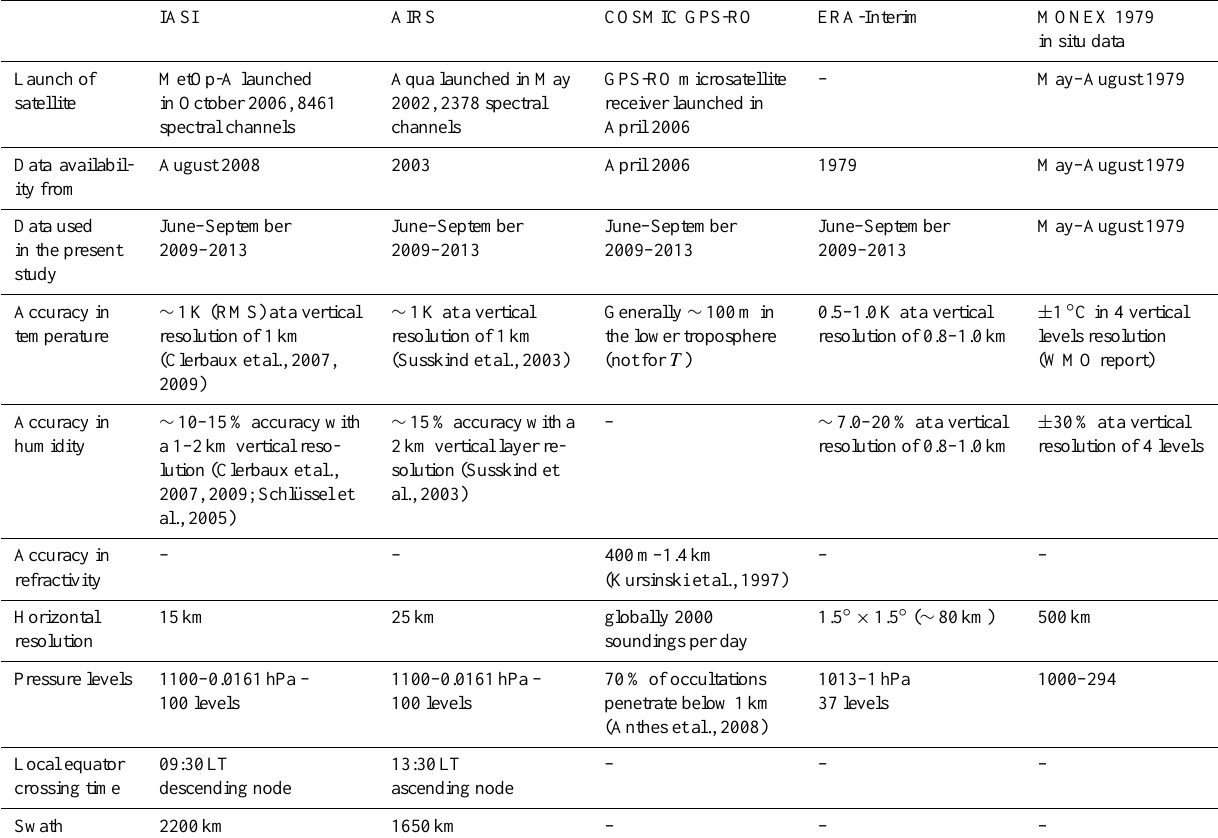
Table 1. Data details for accuracy and/or error and